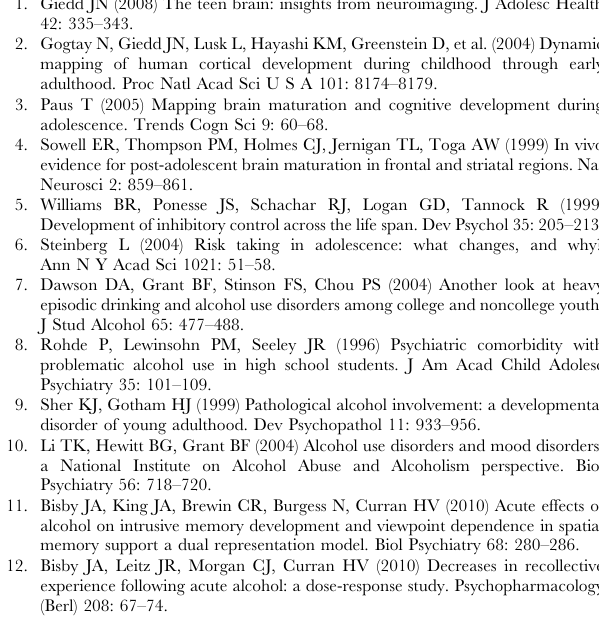
figural memory by acute ethanol: age-dependent effects. Alcohol Clin Exp Res 22: